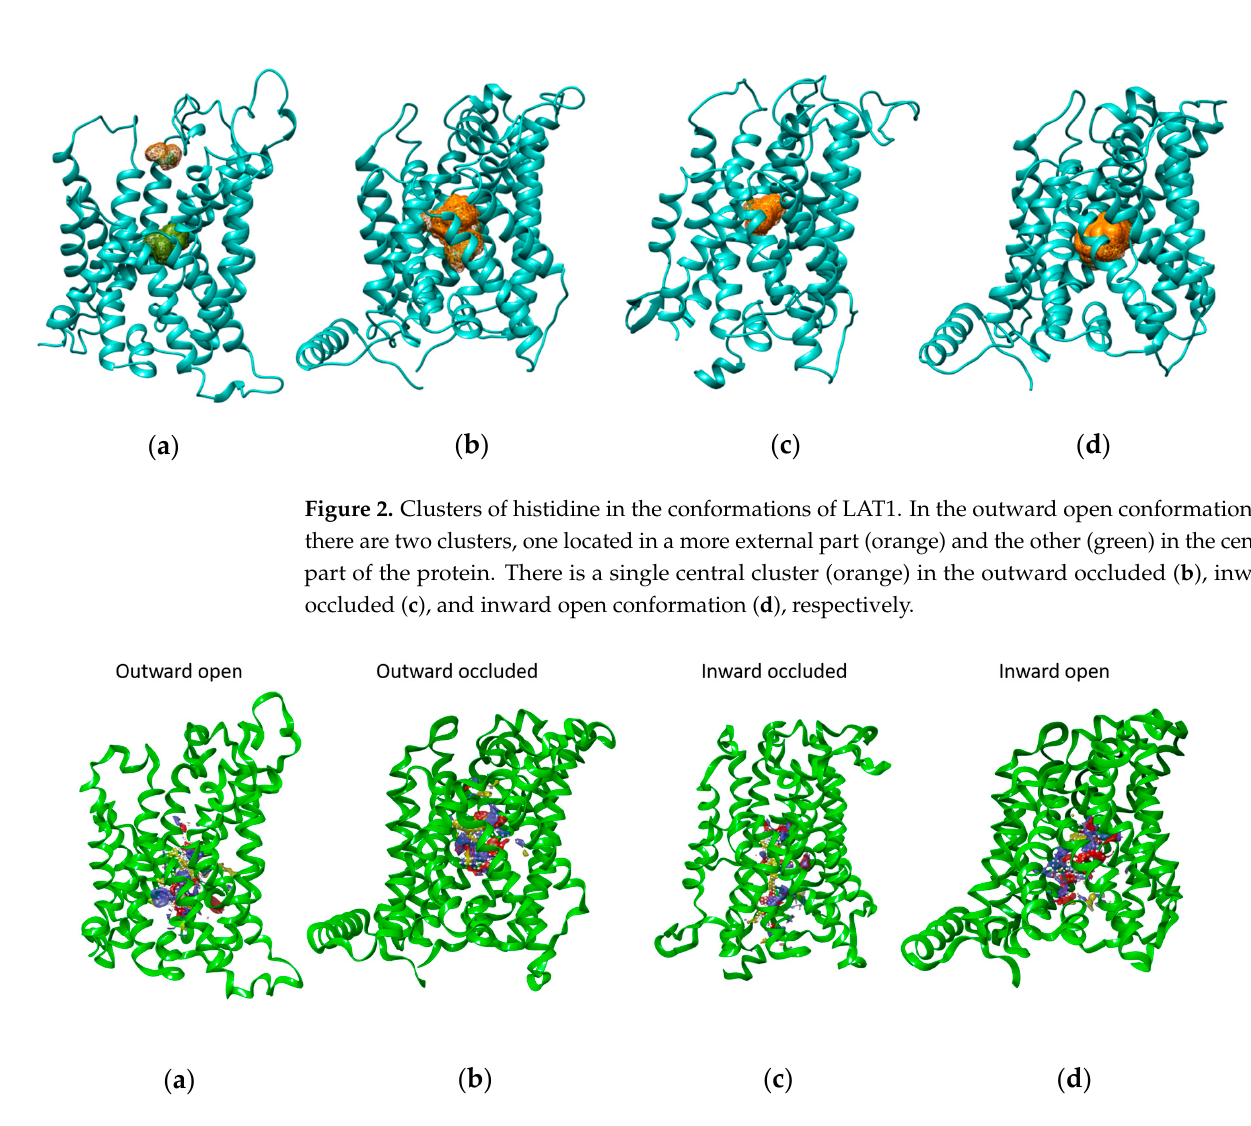
( d ) Figure 4. Surface analysis of LAT1 structures. Images show the surface of the transporter in the four different conformations ( a – d ). Structure surfaces were “cut” perpendicularly to the lateral view of the structures, by controlling the near clipping planes of the Side View Tool from UCSF Chimera [27]. The extracellular side corresponds to the upper part of the transporter structures. 2.2. Docking Analysis The coordinates from clusters obtained by blind docking were used to generate the grid boxes on each structural conformation of LAT1 to carry out standard precision dock- ing for the 20 amino acids. The histidine path is shown as an example of the sub- strate/transporter interactions during the transport cycle (Figure 5). The main residue for histidine recognition is F252, depicted in orange in Figure 5. Indeed, this residue was pre- viously identified as crucial for LAT1 activity by site-directed mutagenesis [28]. F252 in- teracts with or is close to the substrate in all the conformations. In Figure 5, the binding site zoom and the interactions of histidine with the residues predicted by the docking analysis are shown. From the extracellular to the intracellular side, the first step was the outward-open conformation with histidine interacting with the residues E309, V311, and T154 and a Glide Score (G.S.) of − 5.72 kcal/mol) (Figure 5a,e,e’). Then, histidine moves down to interact with S66, F252, and F400 (G.S. = − 5.09 kcal/mol) (Figure 5a,f,f’). In the second step, which is outward occluded, histidine interacts with I63, S66, G67, F252, A253, and G255 (G.S. = − 6.03 kcal/mol) (Figure 5b,g,g’); in the third step, the structure changes to the inward-occluded conformation in which histidine interacts with I63, F252, G255, and S338 (G.S. = − 5,31 kcal/mol) (Figure 5c,h,h’); in the fourth and final step that is inward open, histidine interacts with G67, F252, G255, and F400 (Figure 5d,i,i’). In this structure,